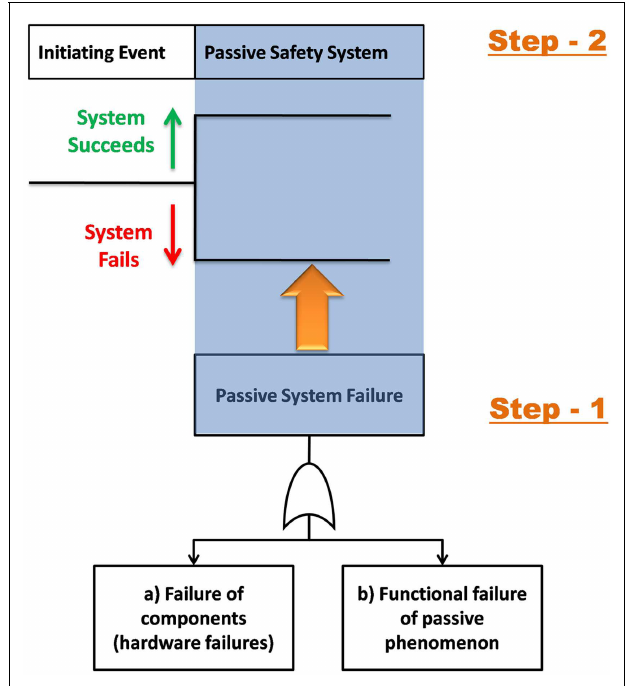
FIGURE 1 | Integration of passive system into plant-specific PSA